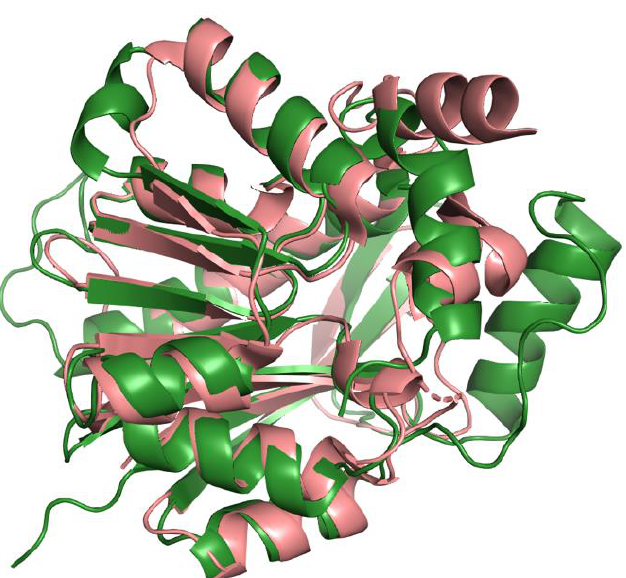
Figure A1. Structural alignment of the human COQ3 model (shown in dark green) and the crystal structure of E. coli UbiG, apo form (shown in pink, PDB: 4KDC). Residues 1 – 90 and 337 – 369 of the AlphaFold model were omitted due to disordered structure. Alignment was performed using PyMOL.